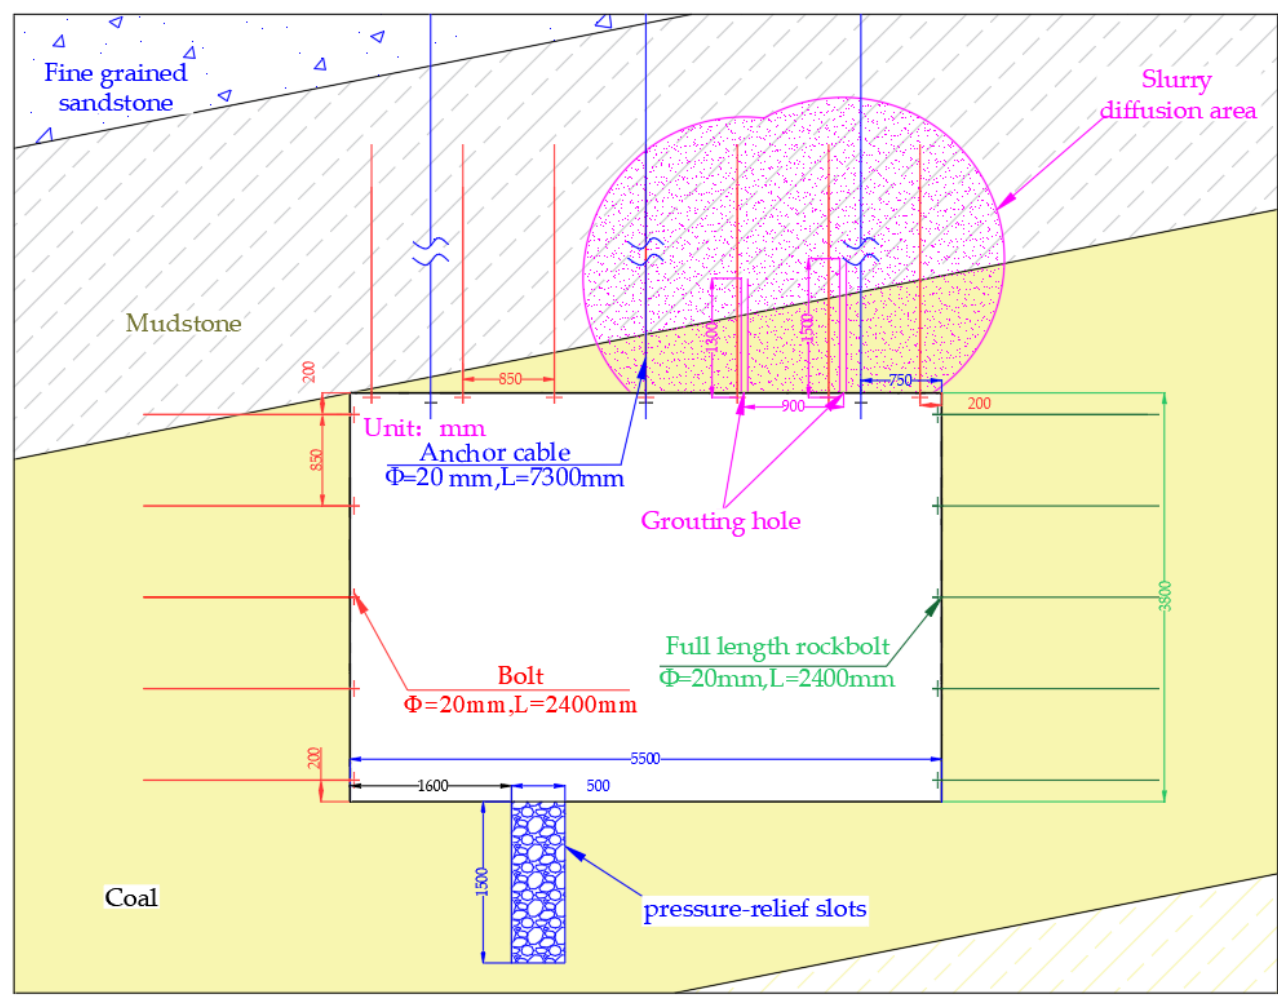
Figure 17. Support scheme of a large-section roadway of gently inclined soft coal seams. The average inclination angle of the lower coal group is 16 ◦ . Area I is grouted for reinforcement, with two grouting holes in each row. The first row of holes is 1300 mm deep and 900 mm from the roadway centerline; the second row of holes is 1500 mm deep and 1800 mm from the centerline. The grouting material is Jinan Reinforcement 1 # . The bolts in area II are supported by full-length anchoring, and the number of anchoring agents is increased from two to three for each. Pressure-relief grooving is performed in area IV, and the pressure-relief groove is 1600 mm away from the left side of the roadway with a groove depth of 1500 mm and a width of 500 mm. Other support patterns remain the same as the original support patterns. Two surface displacement monitoring stations are set up along the belt grooves of the 2103 working face to test the effects of field applications (see Figures 18 and 19 for the monitoring results).